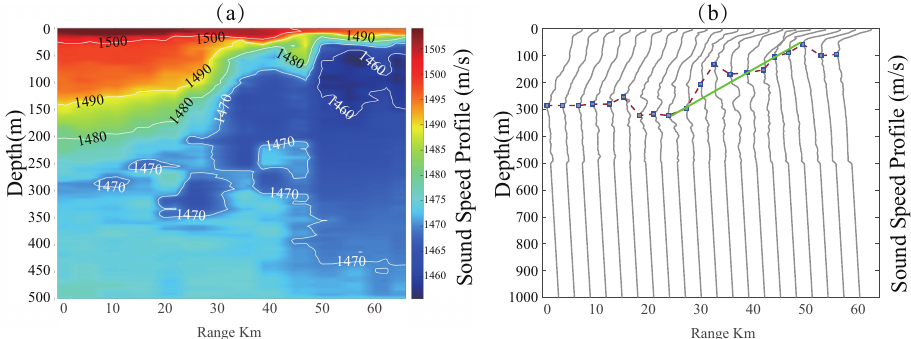
Figure 10. Distribution of sound speed profile on Longitude and depth, ( a ) vertical slice map and ( b ) Those sound speed profiles are equally divided into 20 slices in 60 km of range, green line shown the position of oceanic front and blue dot is the sound channel